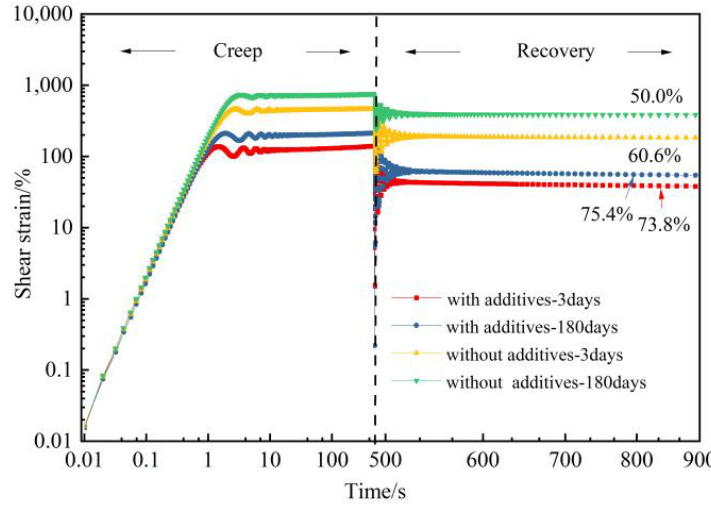
Figure 10. Creep and creep recovery test of polymer gel with and without addicatives.